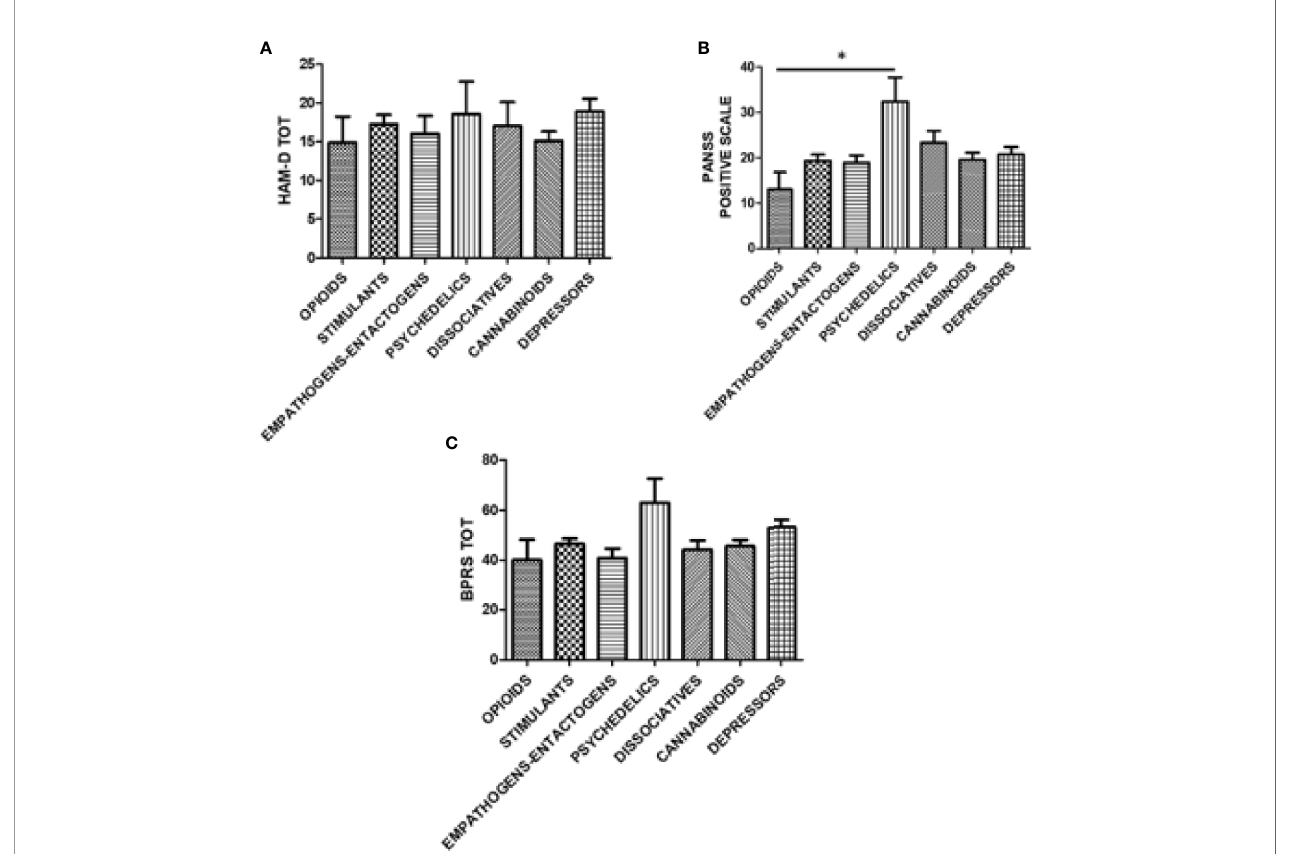
FIGURE 6 | Hamilton Depression (HAM-D) Scale, Positive Syndrome Scale (PANSS), and Brief Psychiatric Rating Scale (BPRS) scores according to groups of substances. (A) HAM-D scale score according to the following groups of substances: opioids, stimulants, empathogens-entactogens, psychedelics, dissociatives, cannabinoids, and depressors. (B) PANSS positive score according to the following groups of substances: opioids, stimulants, empathogens-entactogens, psychedelics, dissociatives, cannabinoids, and depressors; *p < 0.05. (C) BPRS score according to the following groups of substances: opioids, stimulants, empathogens-entactogens, psychedelics, dissociatives, cannabinoids, and depressors.